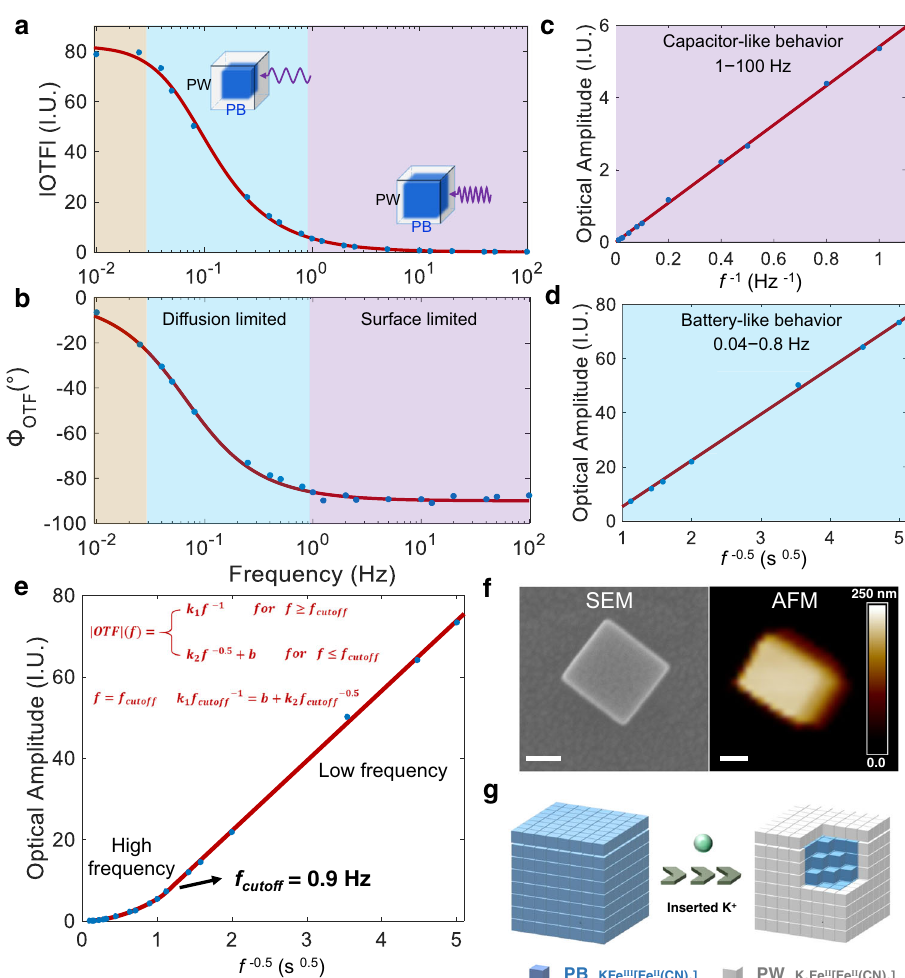
Fig. 2 The oEIS of single PBNPs and corresponding mechanism analysis. a Bode plots of OTF amplitude and ( b ) phase of single PBNPs as a function of modulation frequency. The purple, blue and orange area represent the high-frequency region, low-frequency region and depletion region, respectively. The red line shows the simulated results from equivalent circuit which will be discussed in the following section (function 3&4), and the blue dots are experimental data. c Surface pseudocapacitive behavior in the high-frequency region. d Diffusion-limited behavior in the low-frequency region. e When plotting optical amplitude as a function of f − 0.5 , the dependence can be well fi tted by a piecewise function as shown in the ( e ) inset to determine the corner frequency ( f cutoff ). The red line is the fi tted results, and the blue dots are experimental data. f Correlative SEM and AFM images of the same PBNPs examined in ( a – d ). Scale bar: 100 nm. g Schematic diagram of the “ shell-to-core ” model showing the transformation from entire PB to PW. Source data